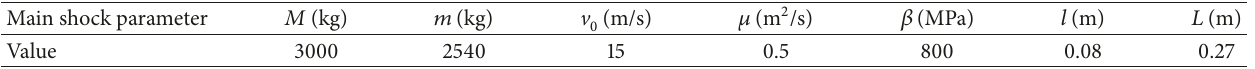
Table 1: Main shock parameter